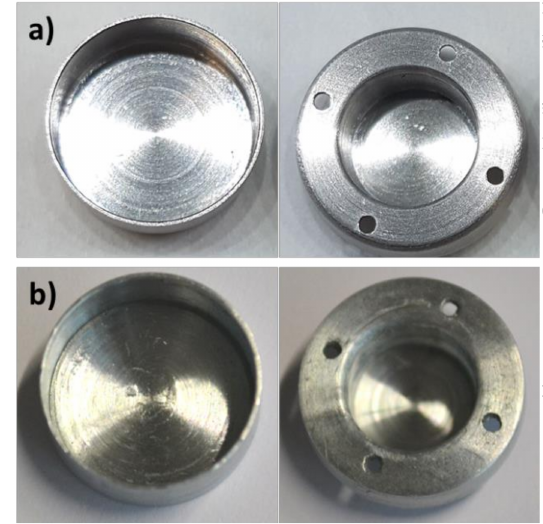
Figure 3. Contact angle of molten Solar salt at 300 ◦ C on the surface of ( a ) alumina, PtRh-alloy, sapphire, SS316 (wetting condition) and on the surface of ( b ) magnesium, zinc, silver and SS316 coated with gold (non-wetting condition).